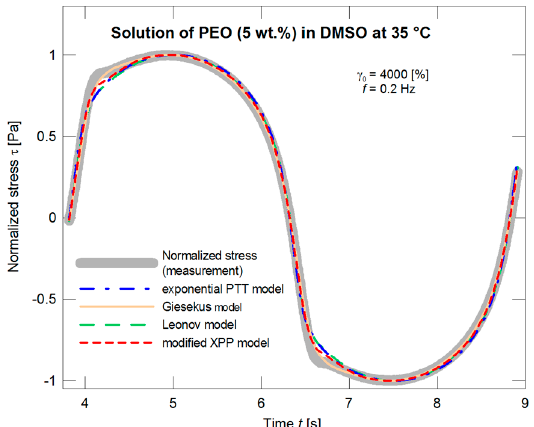
Figure 8. A description of normalized stress by the exponential PTT, Giesekus, Leonov, and modified XPP models using the nonlinear parameters optimized with respect to the steady shear viscosity measurements (Figure 4).